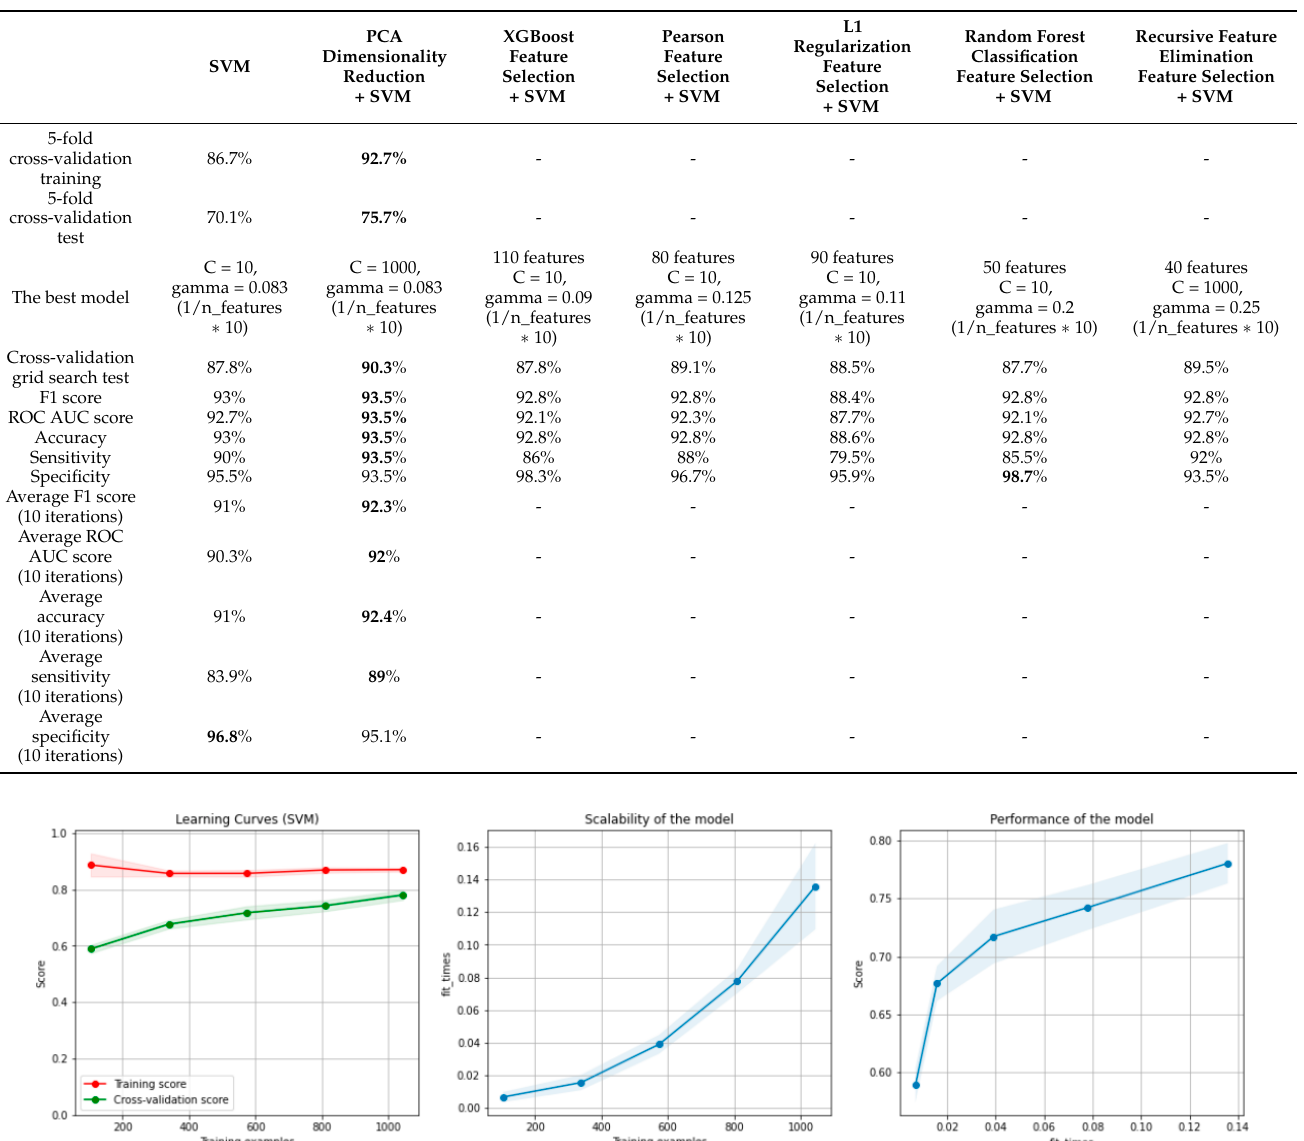
Table 1. Results of the SVM algorithm applied on the non-overlapping dataset.